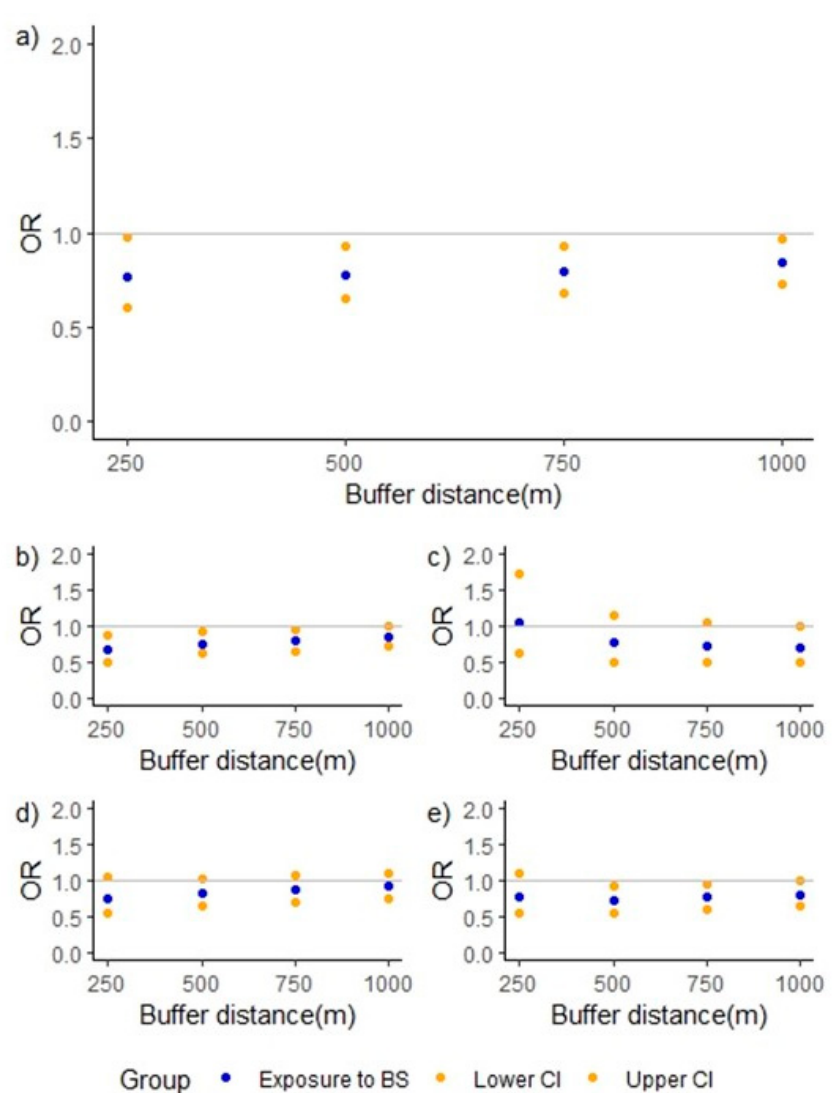
Figure 2. Adjusted models’ graphical representations. Blue points represent ORs, blue-space exposure for each buffer distance compared to the reference group (subjects who did not have any blue space in their 1 km exposure buffers). Lower and upper 95%CIs are represented by orange points. ( a ) Overall childhood leukaemia, ( b ) ALL subtype, ( c ) AML subtype, ( d ) Cases with same address at birth and diagnosis, ( e ) cases <3 years old.